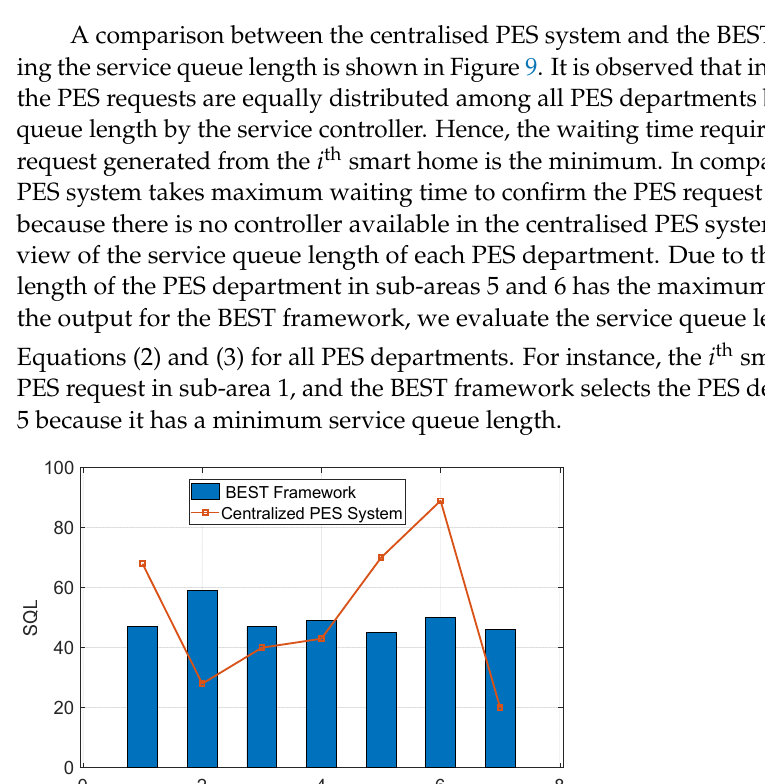
Figure 8. Evaluation of SQL for PES departments.